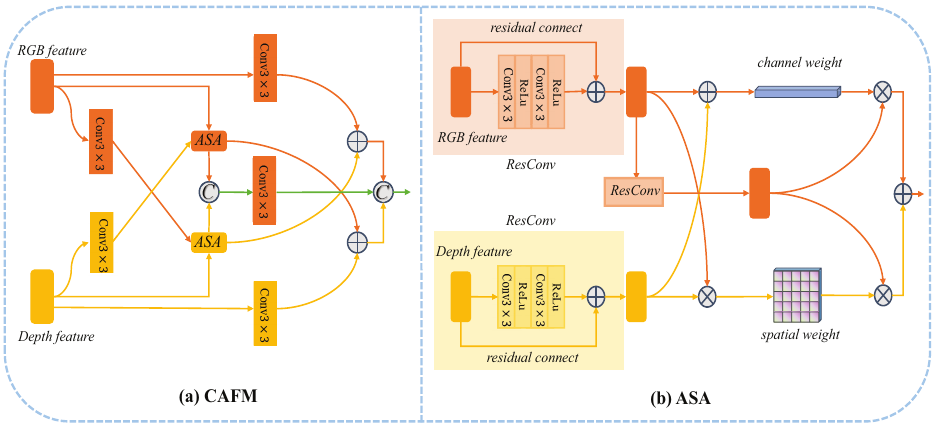
Figure 3. The structure of the cross-modal alternate fusion module